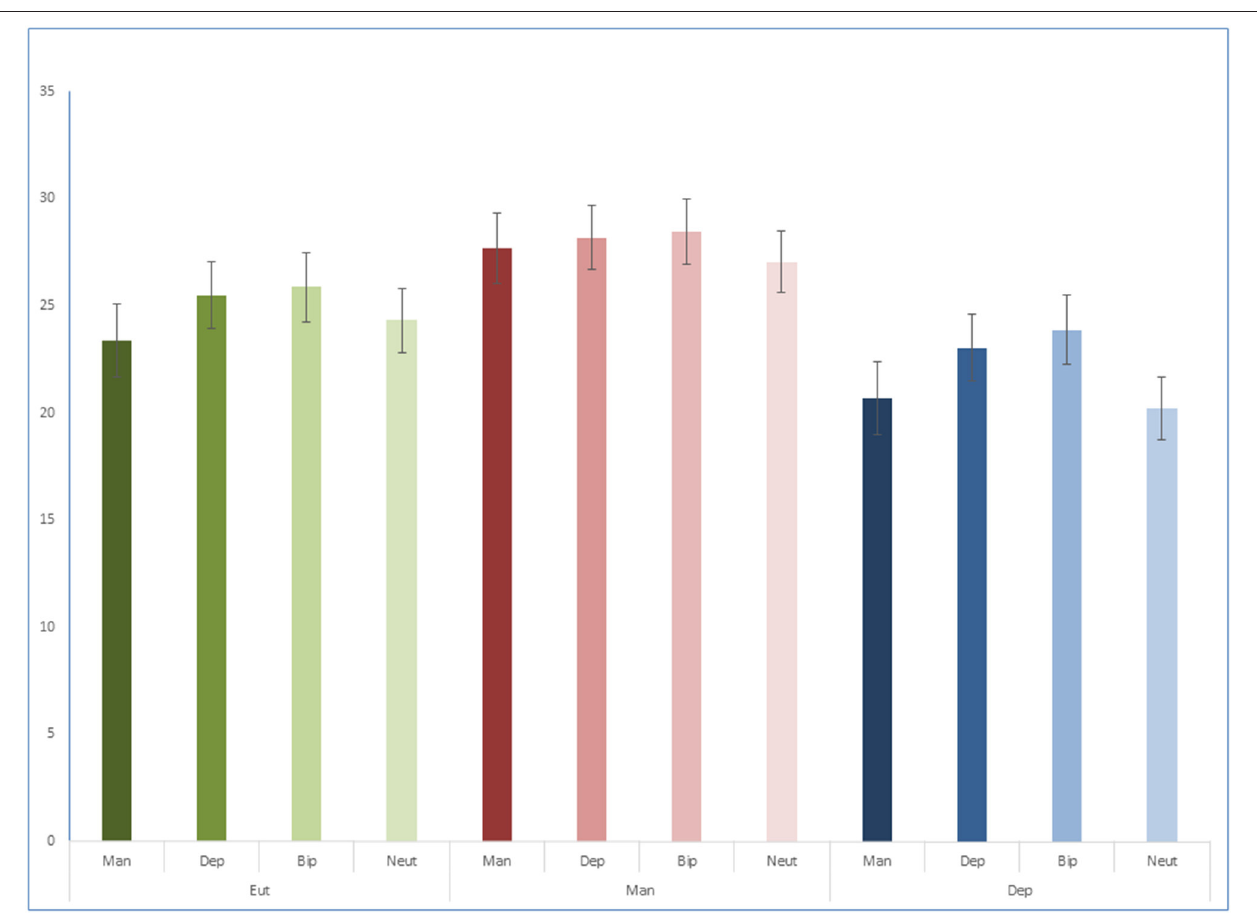
FIGURE 1 | Total episodic detail